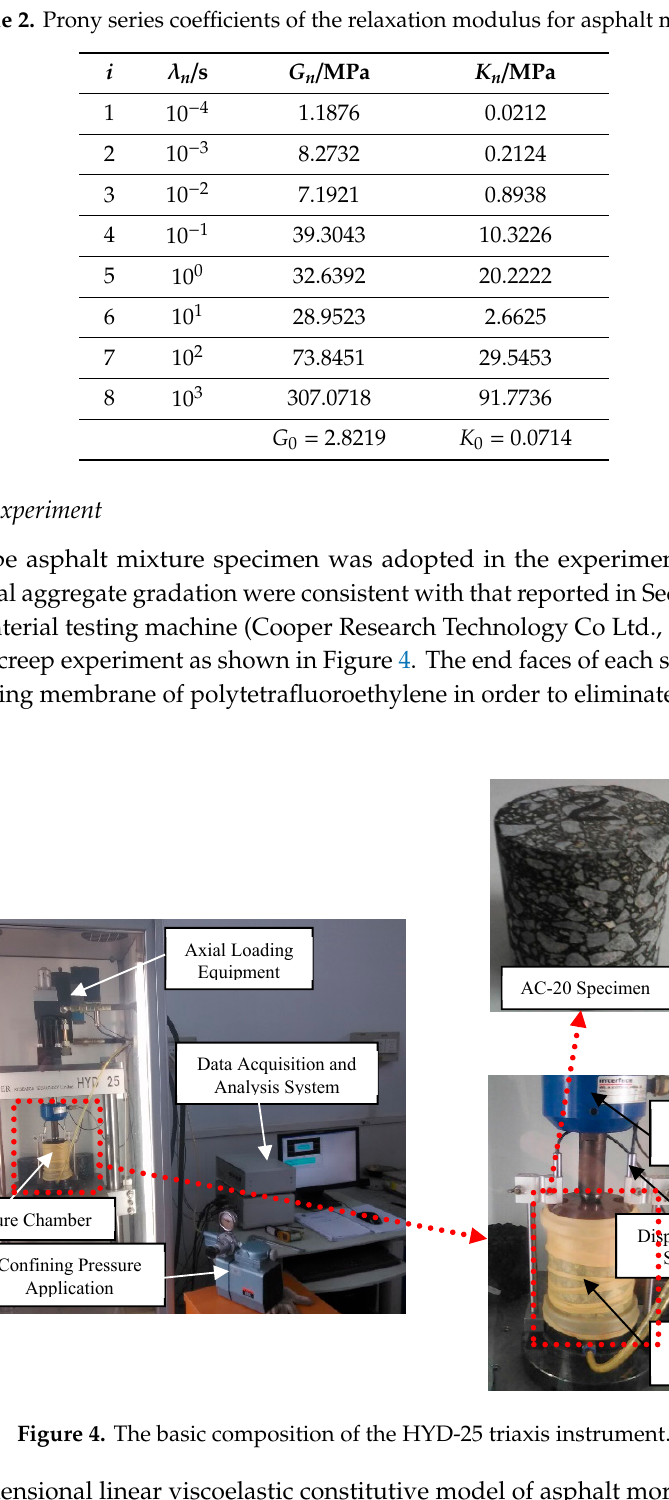
Table 3. Loading scheme of triaxial creep test for asphalt mixture.